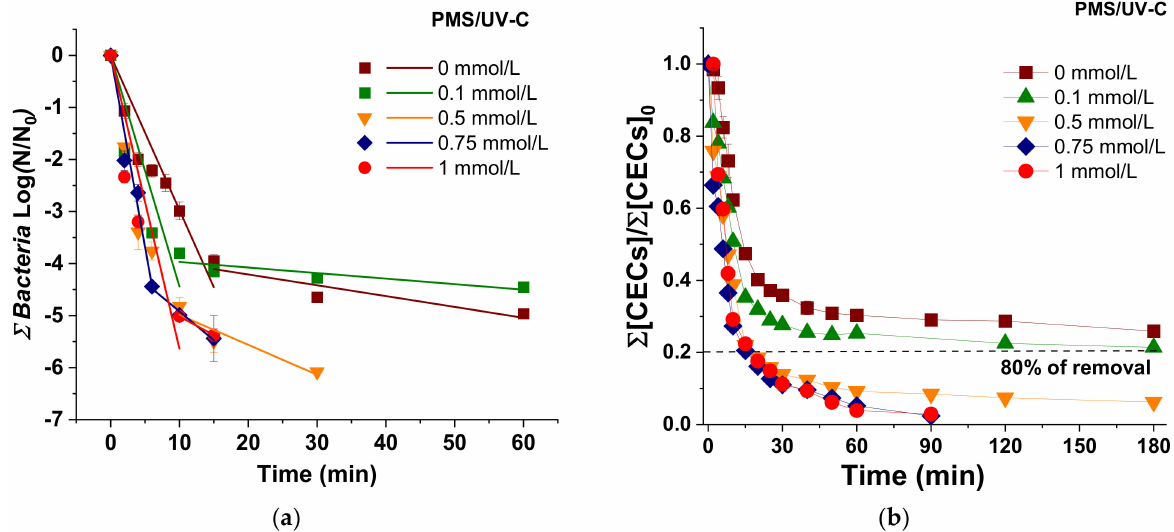
Figure 2. ( a ) Linear fitting of sum of bacteria inactivation; ( b ) Degradation of total CECs in UWW under UV-C irradiation in the presence of increasing concentration of PMS (0–1